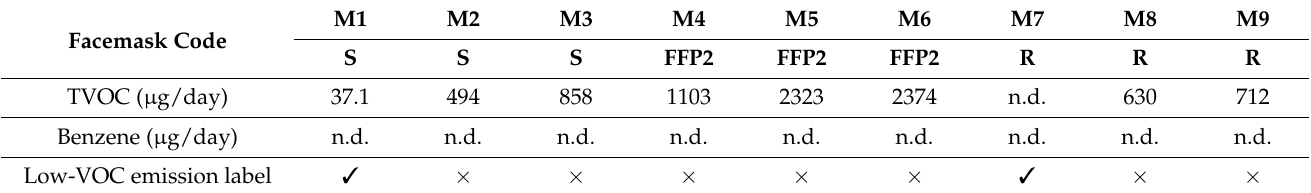
Table 5. TVOC and Benzene ( µ g/day) concentration and application of the proposed